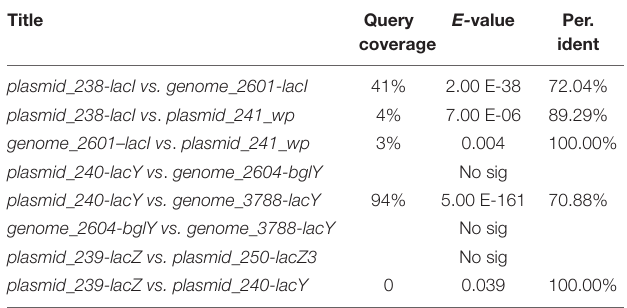
TABLE 3 | Sequence similarity of lac operon related